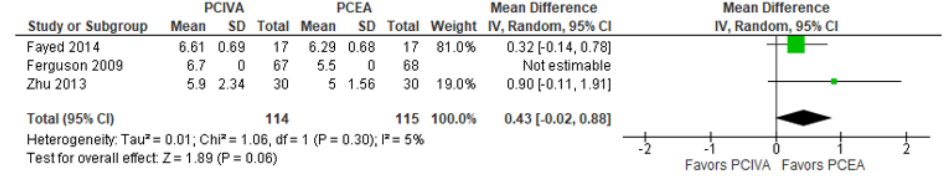
Figure 3. Postoperative pain scores on coughing (at 24 h) [19 – 21].